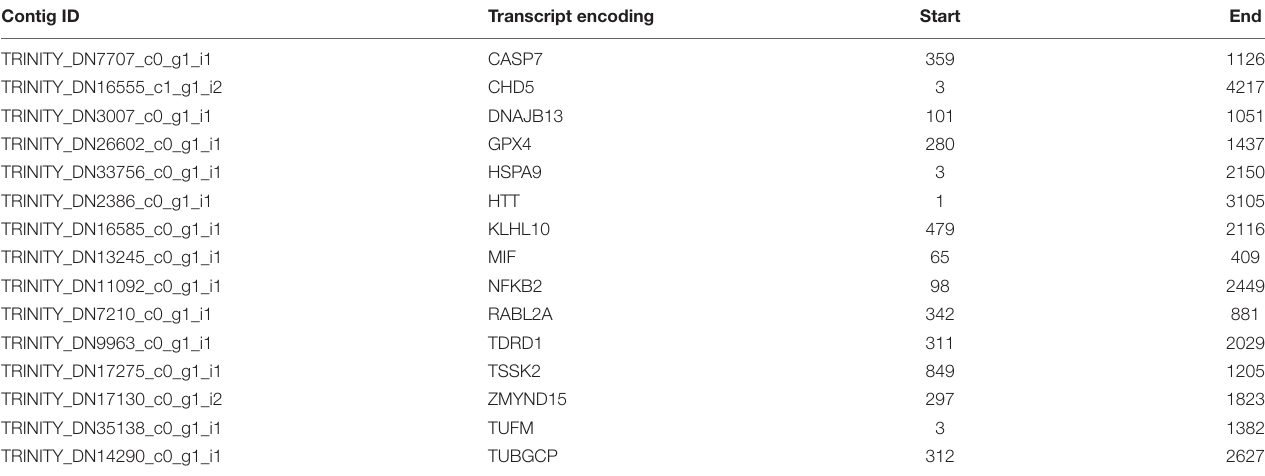
TABLE 3 | Longest ORF regions of the differential expressed transcripts used in qPCR. Contig ID Transcript